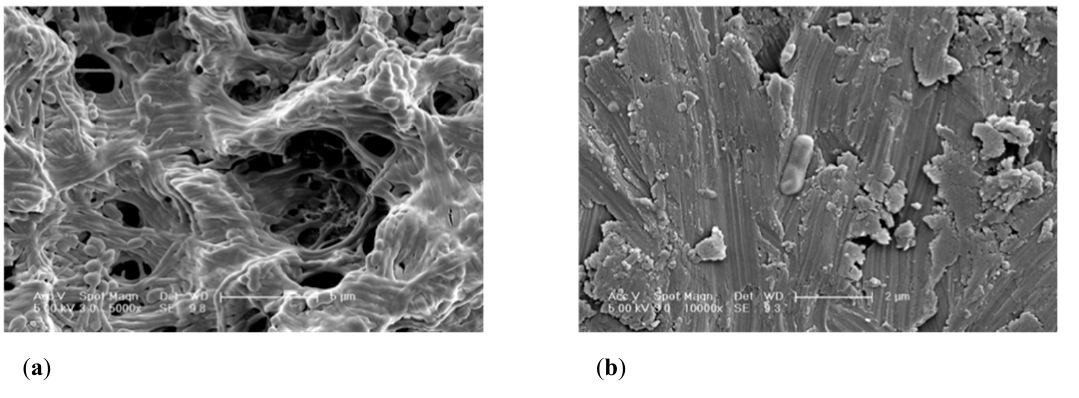
Figure 1. Scanning electron microscopy images showing ( a ) MC biofilm grown on top of Ti M substrata (scale bar = 5 µ m, magnification 5000 × ), and ( b ) M Ti surfaces following disinfection employing T1 (scale bar = 2 µ m, magnification 10,000 × ).